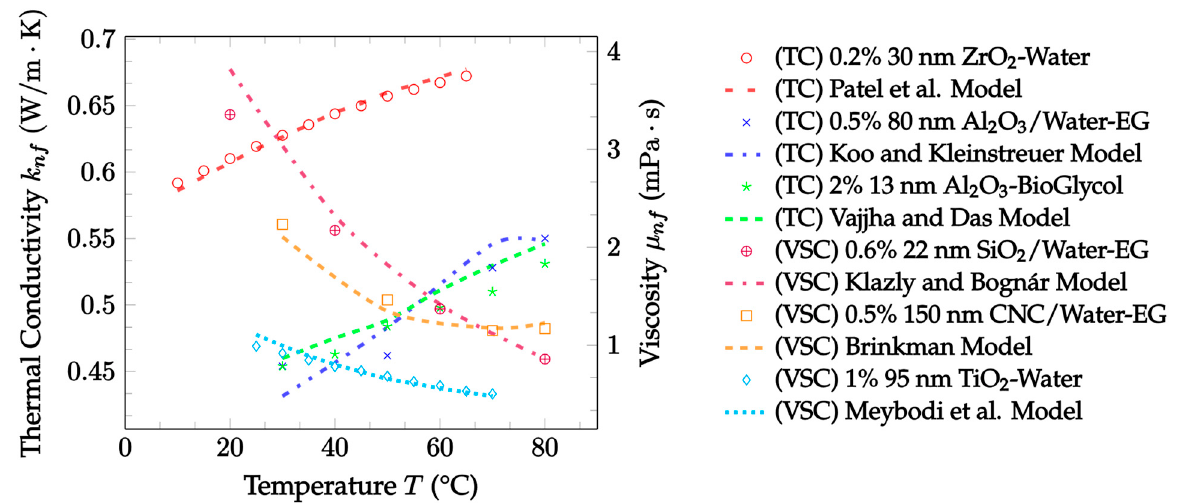
Figure 19. Thermal conductivity and viscosity of nanofluids as a function of temperature with additional theoretical correlations: (TC) 0.2% 30 nm ZrO 2 –water [65], Patel et al. Model [23], (TC) 0.5% 80 nm Al 2 O 3 /Water–EG [113], (TC) Koo and Kleinstreuer Model [21], (TC) 2% 13 nm Al 2 O 3 - BioGlycol [114], (TC) Vajjha and Das Model [22], (VSC) 0.6% 22 nm SiO 2 /EG–water [115], (VSC) Klazly and Bognár Model [52], (VSC) 0.5% 150 nm CNC/Water–EG [113], (VSC) Brinkman Model [48], (VSC) 1% 95 nm TiO 2 –water [116], (VSC) Meybodi et al. Model [49].